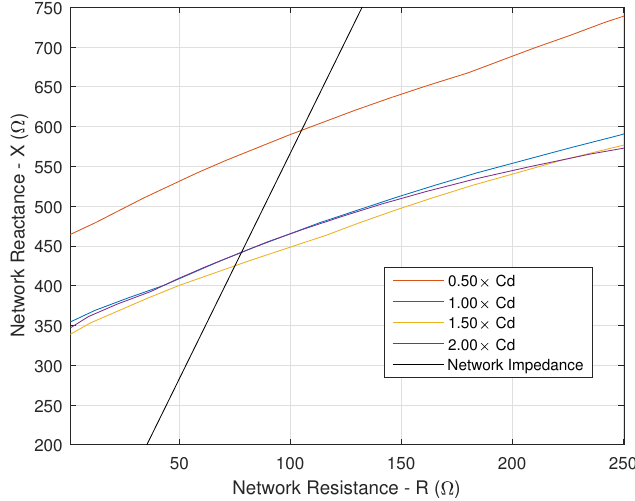
Figure 19. Stability limit curve of a traction chain in the network reactance ( X ) and resistant ( R ) complex plane. Variation of DC-link capacitance.